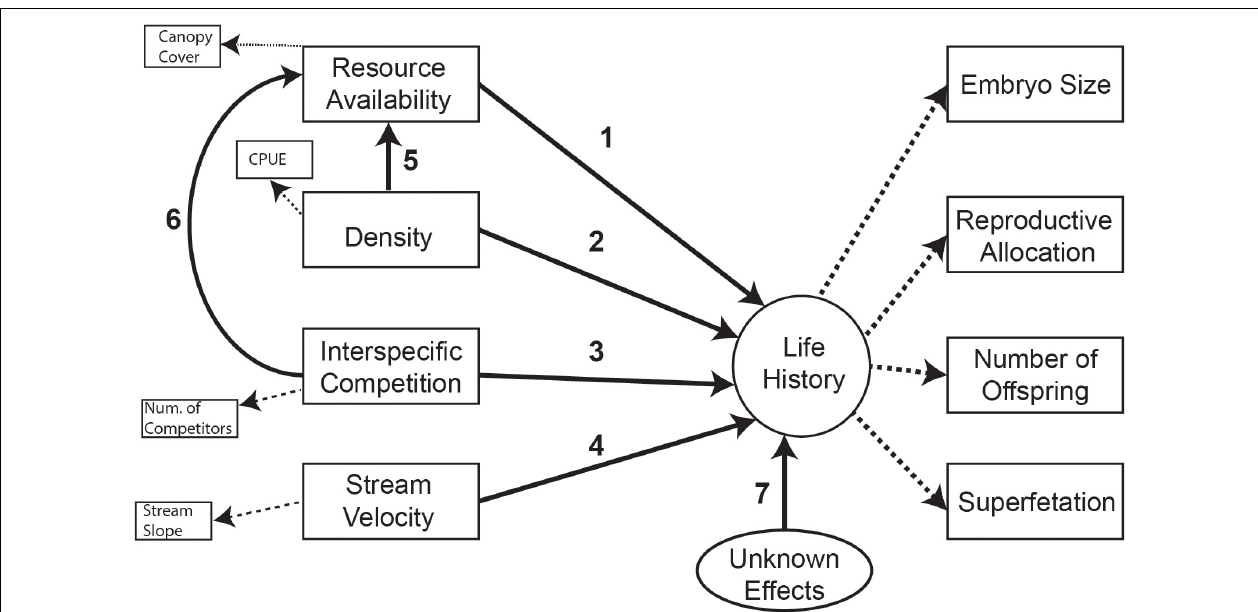
FIGURE 2 | Path diagram of the global model with both direct and indirect effects of four putative selective agents on life histories. Numbers above each path line correspond to path ID (also found in Table 1 and Table 4 ).